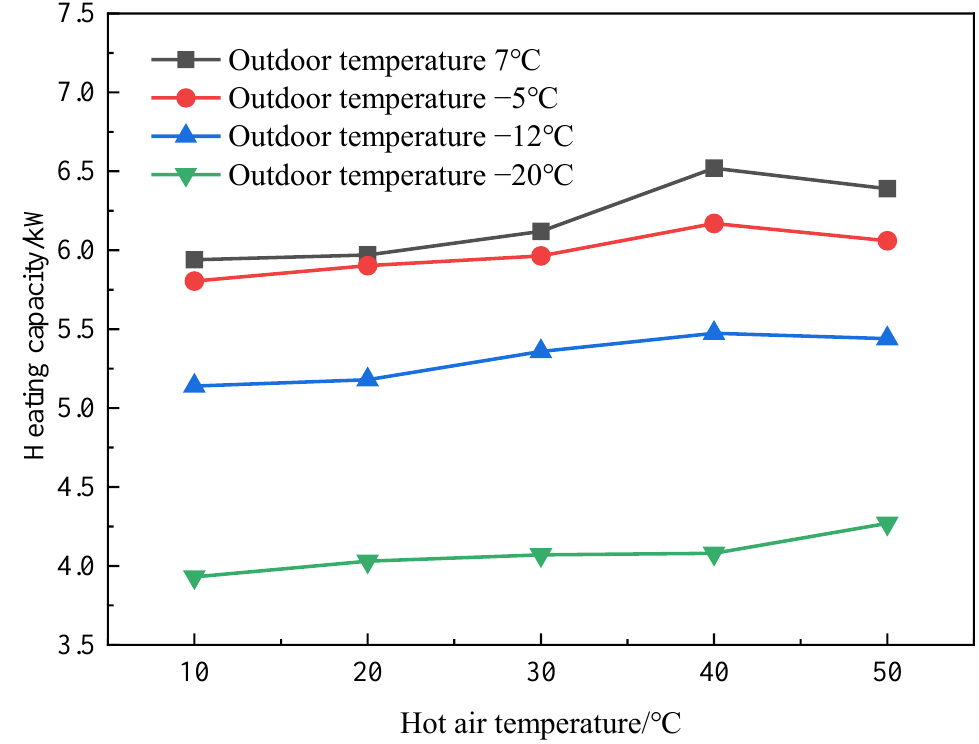
Figure 9. Heating capacity of the SC-EVIHP system. Comparison of the COP of the SC-EVIHP system at different outdoor temperatures and different hot air temperatures is shown in Figure 10. The variation trend of the COP was similar to that of the heating capacity. When the outdoor temperature was −1 2 °C, −5 °C, and 7 °C, respectively, the COP increased first and then decreased with the increase in hot air temperature. When the hot air temperature was 40 °C, the COP reached the maxi- mum value, then it decreased with the rising hot air temperature. The reason is that with the increase in hot air temperature, the evaporation temperature of the system rose grad- ually, thus causing the heating capacity of the system to increase. However, as the hot air temperature continued to rise, the heating capacity of the system decreased. Moreover, as more refrigerant entered circulation, the power consumption of the compressor also in- creased. This resulted in a decrease in COP. When the outdoor temperature was −2 0 °C, the COP gradually increased with the increasing hot air temperature. This indicates that the SC-EVIHP system operates more stably in cold regions.